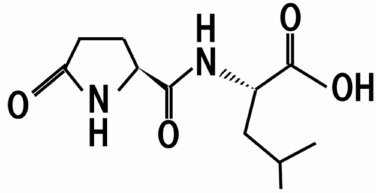
Figure 8. Chemical structure of